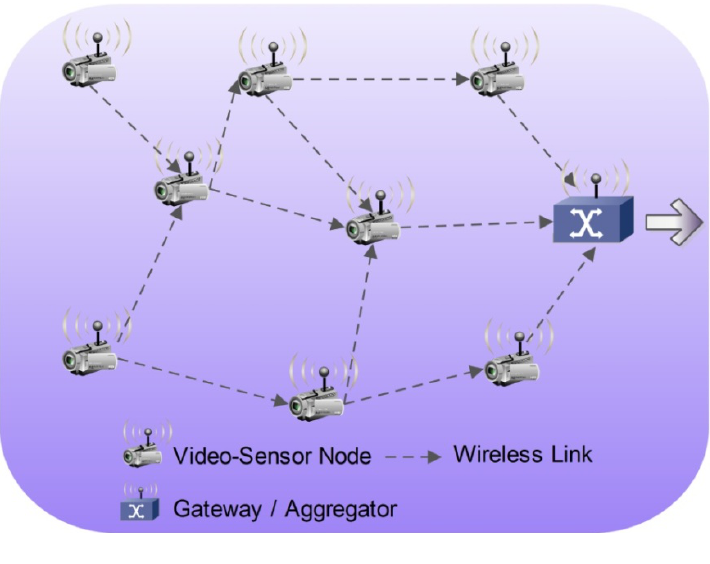
Figure 1. Typical self-organizing wireless